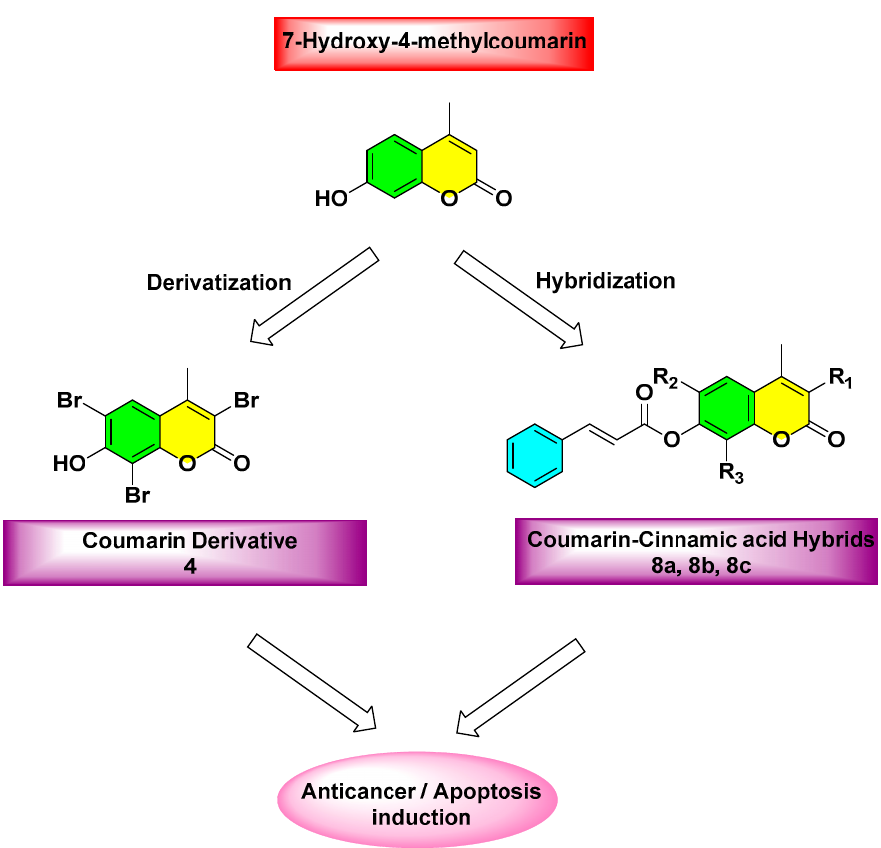
Figure 2. Design of coumarin derivatives and coumarin–cinnamic acid hybrids as anti-cancer agents.